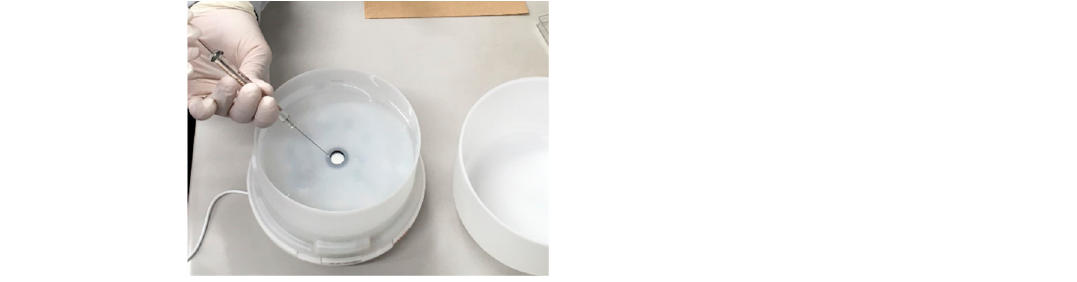
Figure 2. Preparation of diffusing and collecting test: Dropwise 0.5 mL of essential oils and effective component to 350 mL water in the aroma diffuser.